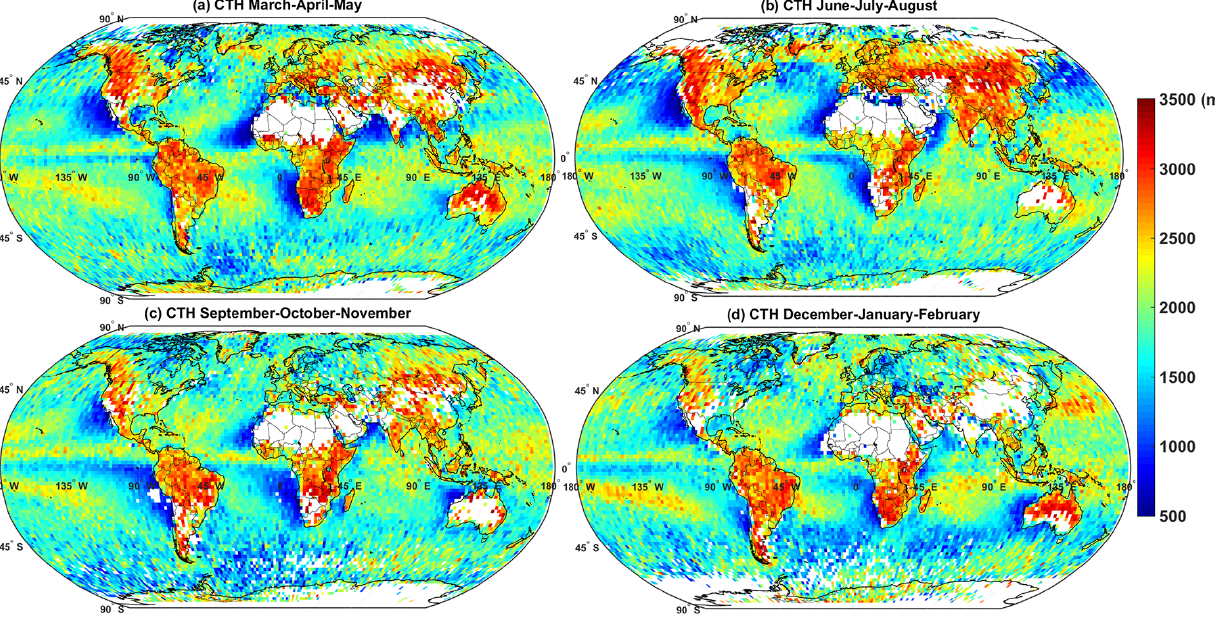
Figure 11. The same as Fig. 10 but for